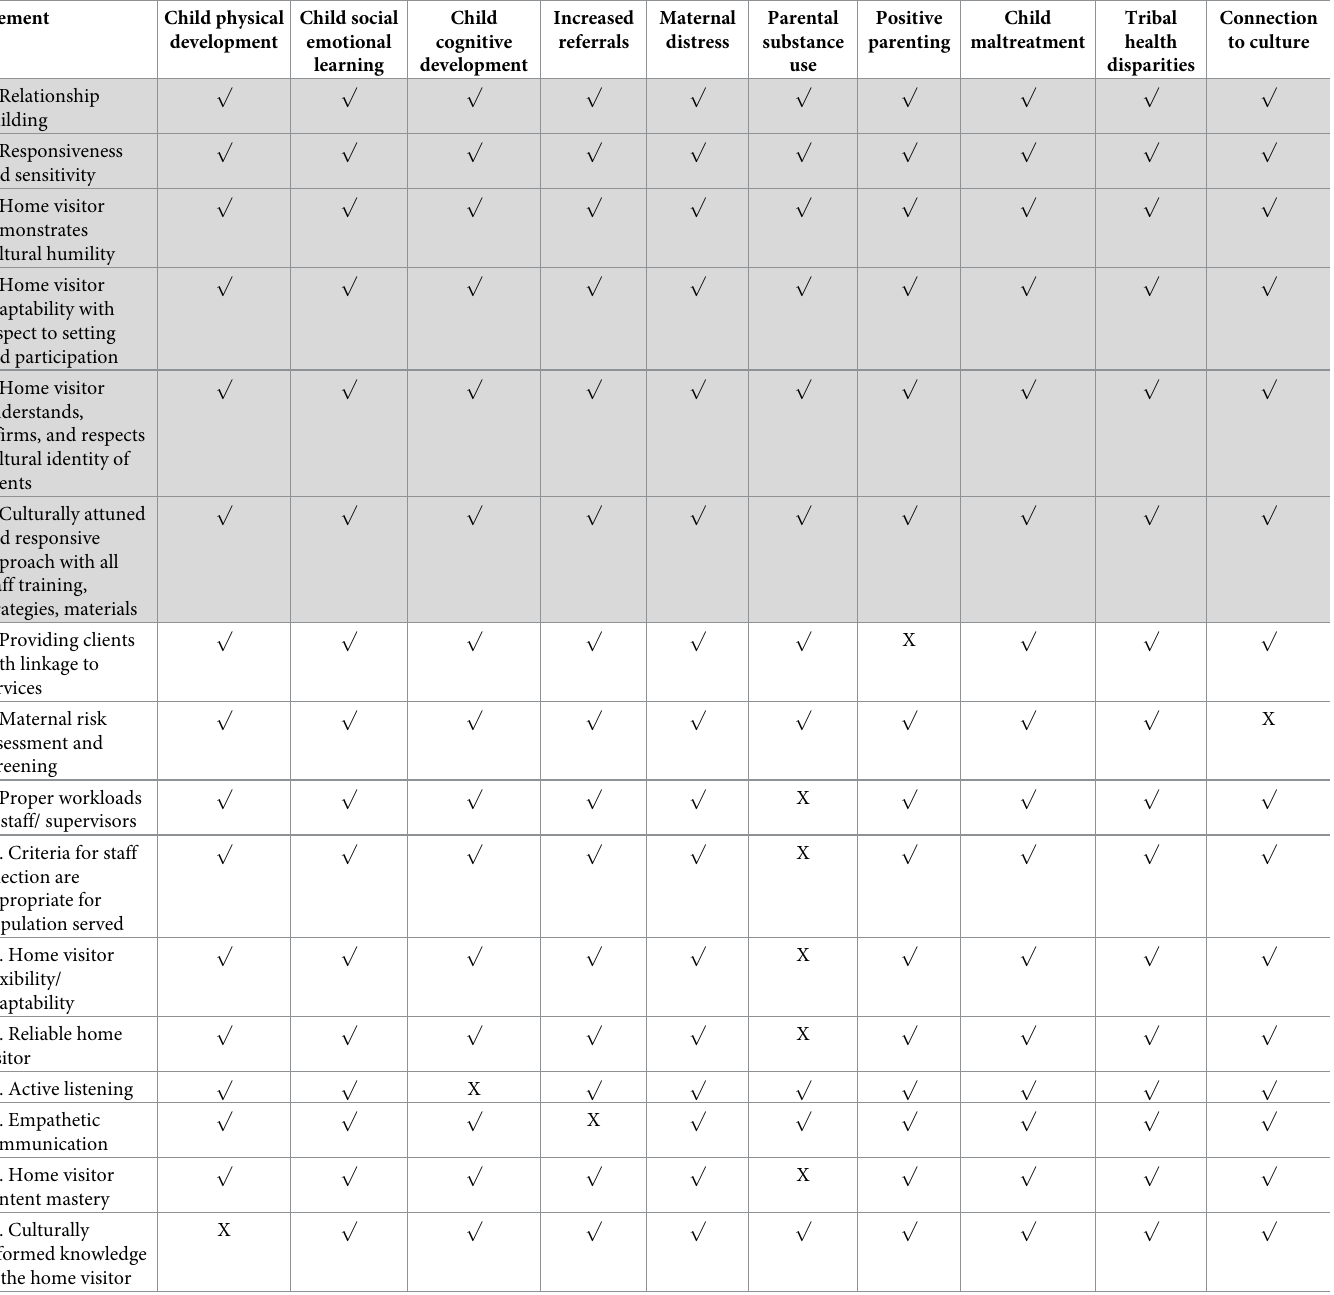
Table 3. Elements classified as essential across 90% or more of the outcome domains.